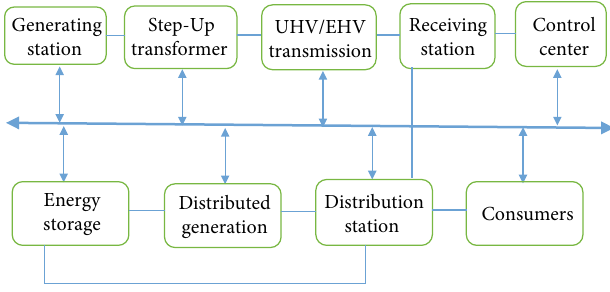
Figure 12: Smart grid